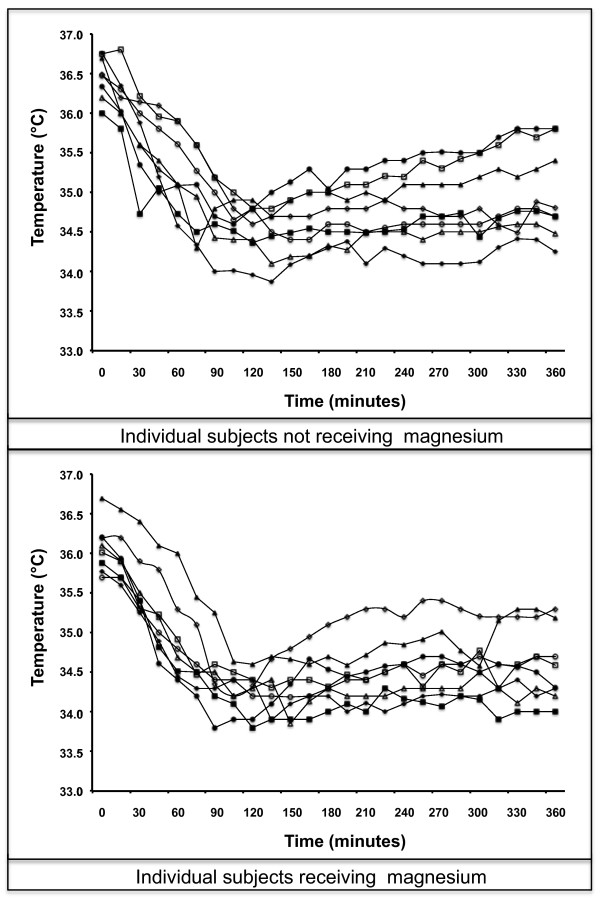
Temperature curves of all subjects. Upper figure: subjects not receiving MgSO4; lower figure: subjects receiving MgSO4.